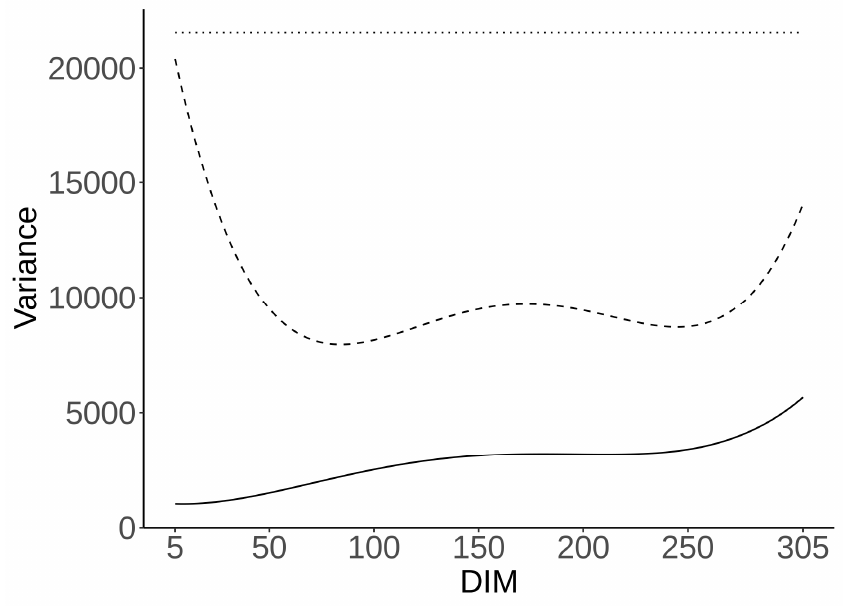
Figure 1. Residual (dotted line), permanent environment (dashed line), and genetic (solid line) variances (ppm/d) 2 throughout lactation for CH 4 ppm/d.